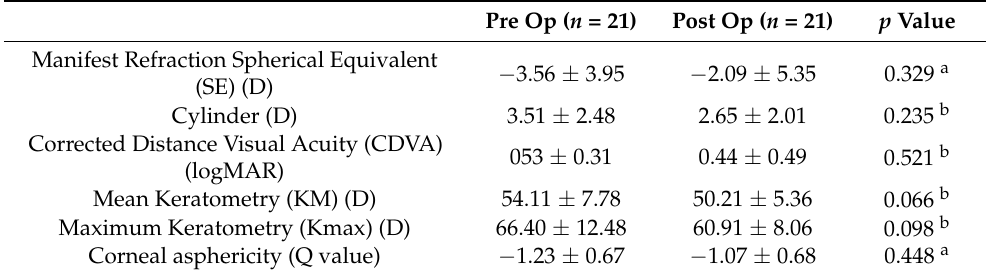
Table 1. Refractive outcomes pre- and post-intrastromal corneal ring segments implantation.